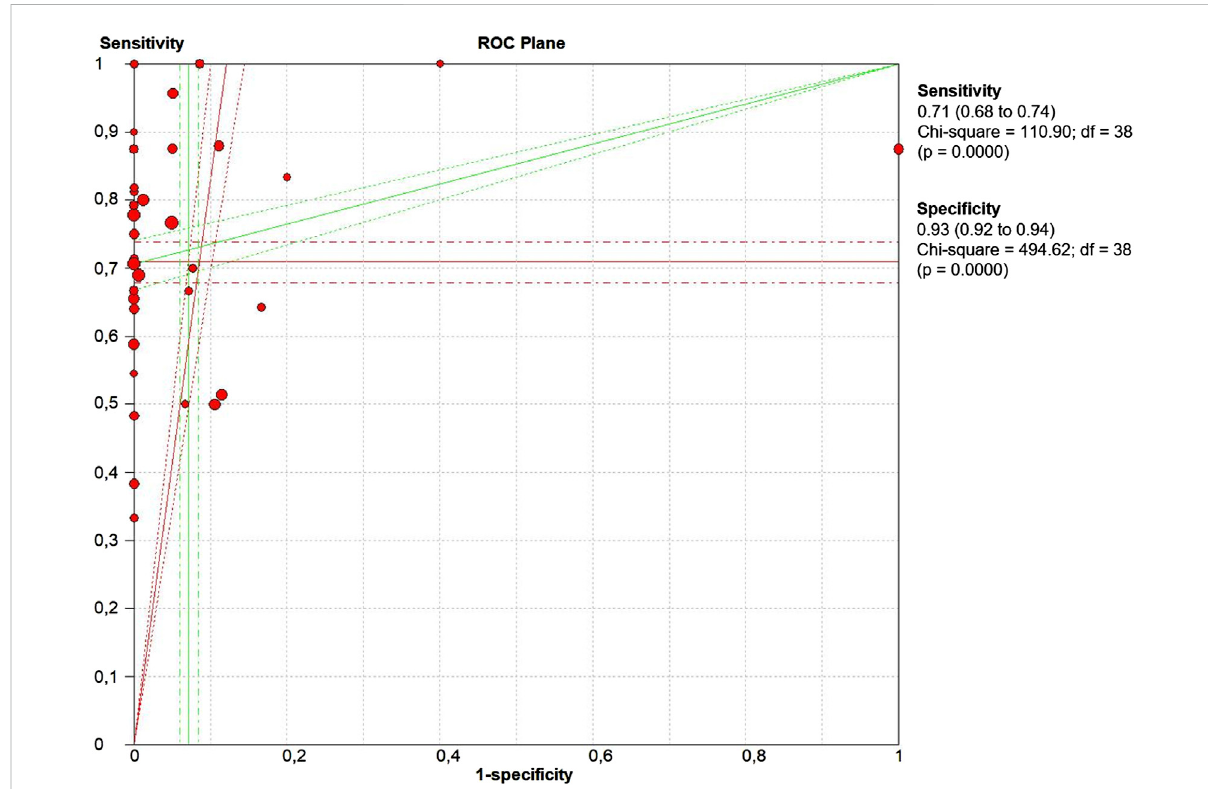
FIGURE 5 The receiver operative curve (ROC) plane plot. Points represent the pair of sensitivity and speci fi city at a given threshold for each study.